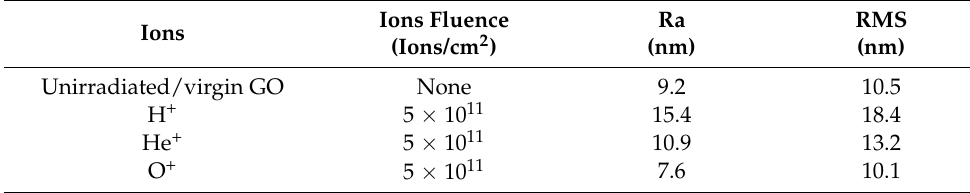
Table 2. List of Ra and RMS values as a function of the H + , He + and O + ion fluences. Ions Ions